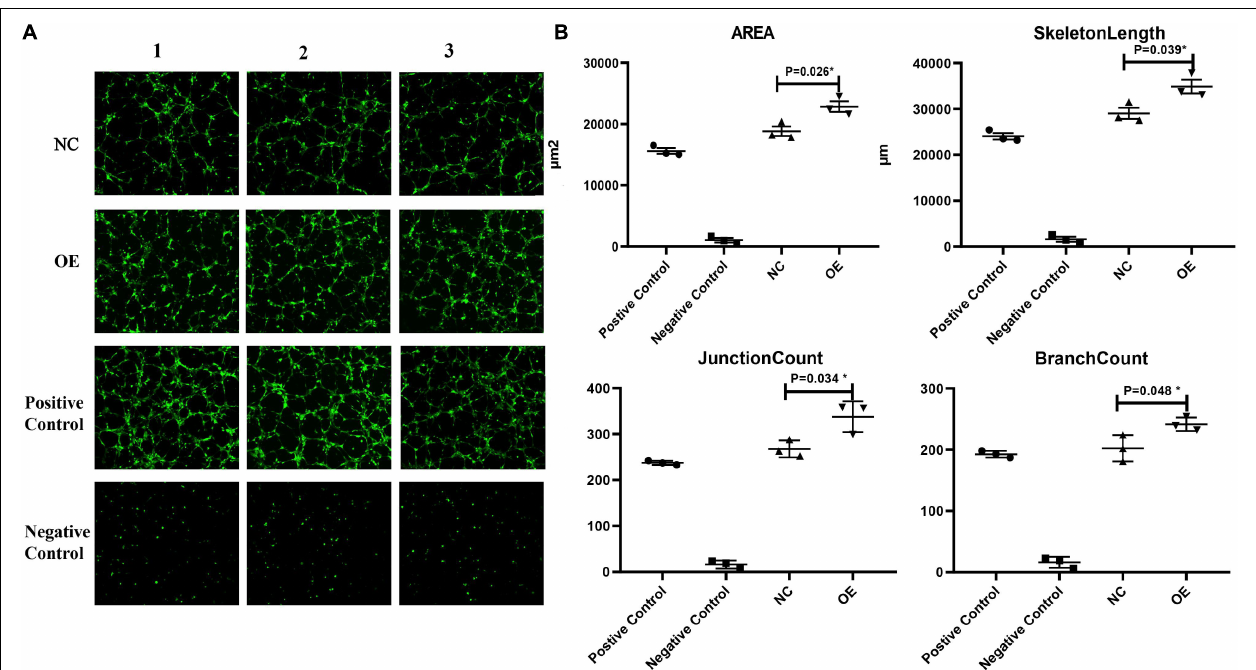
FIGURE 5 | Effect of overexpression of ACTA2 on angiogenesis. (A) Representative fluorescence images of angiogenesis in the positive control, negative control, NC, and ACTA2 overexpressing group. (B) Quantification of Area, Skeleton Length, Junction Count, Branch Count of positive control, negative control, NC and ACTA2 overexpressing group. * P < 0.05, ** P < 0.01, *** P <